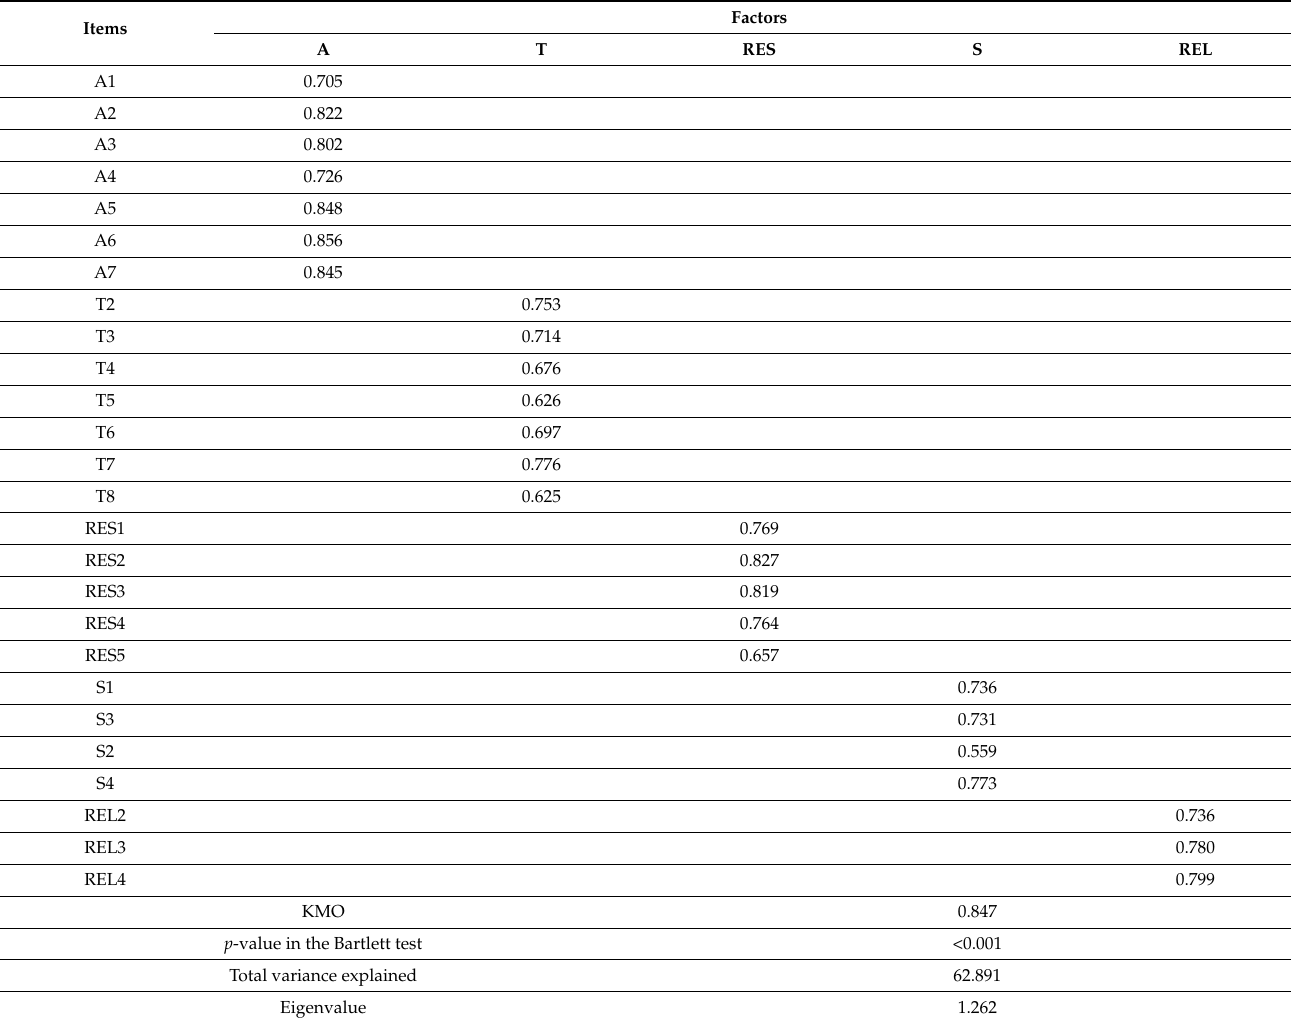
Table 4. Exploratory factor